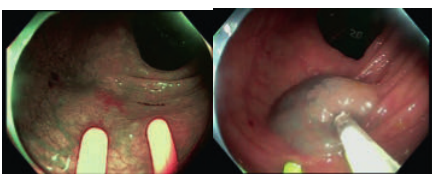
Figure 1a/b: Cecal retroflexion with Endocuff with sessile serrated